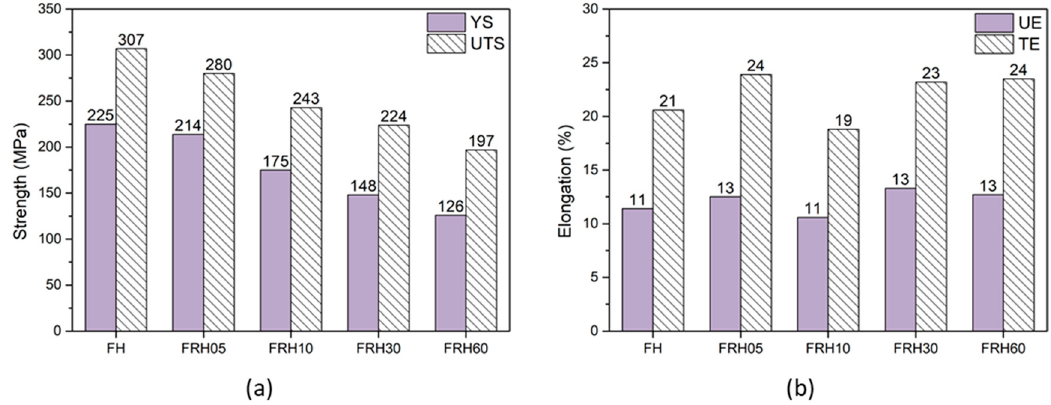
Figure 6. Mechanical properties of ZKX500: ( a ) strength and ( b ) elongation.